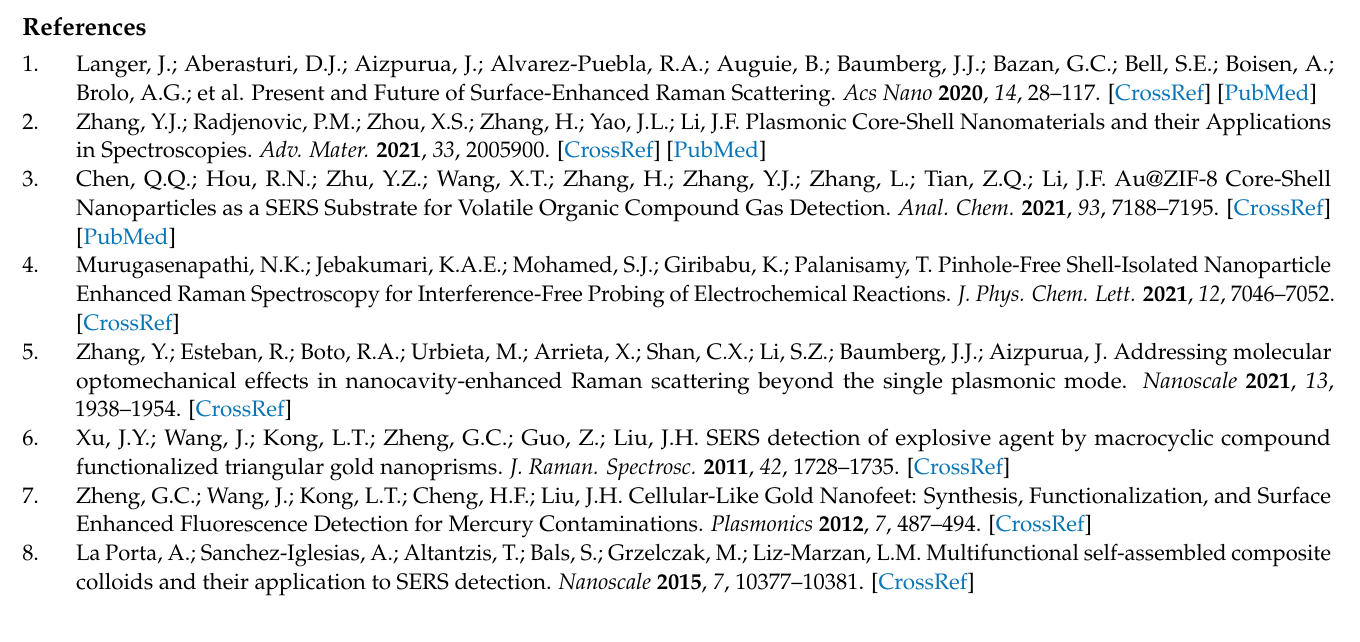
(d) size distribution for silver nanoplates. Figure S2: Photos of Ag nanoplates coated filter paper (1 st–20 th). Figure S3: (a–b) SEM images of pure filter paper. (c–f) SEM images of Ag nanoplates coated filter paper. Figure S4: (a–i) Raman spectra of different concentrations of R6G (10 − 5 M − 10 − 13 M). In (a), the main Raman active vibrational modes are marked. Figure S5: (a) Simulated Raman spectra of R6G molecules (for laser excitation 633 nm, solid curve) obtained by broadening the sticks for individual vibrational modes with Lorentizian function of a width of 20 cm − 1 . (b) The vibrational pattern of the selective Raman active vibrational modes, where white, gray and blue spheres are the hydrogen, carbon and nitrogen atoms, respectively. Figure S6: The Raman signal of filter papers stored at room temperature for 3 days (a), 7 days (b), 10 days (c). (d) Raman intensity histogram of substrates. Figure S7: (a-d) Raman spectra of different concentrations of thiram in acetone (10 − 5 M − 10 − 8 M). In (a), the main Raman active vibrational modes are marked. Figure S8: (a) Simulated Raman spectra of thiram molecules. (e) The vibrational pattern of the vibrational modes, where the white, gray and blue spheres are the hydrogen, carbon and nitrogen atoms, as before, and the yellow and red spheres are sulfur and oxygen atoms. Figure S9: (a–d) Raman spectra of different concentrations of thiram in juice (10 − 4 M − 10 − 7 M). Table S1: Comparison of other substrates. Table S2: The comparison of LOD of Thiram with other works. Table S3: Assignment of SERS peaks to the vibrational modes